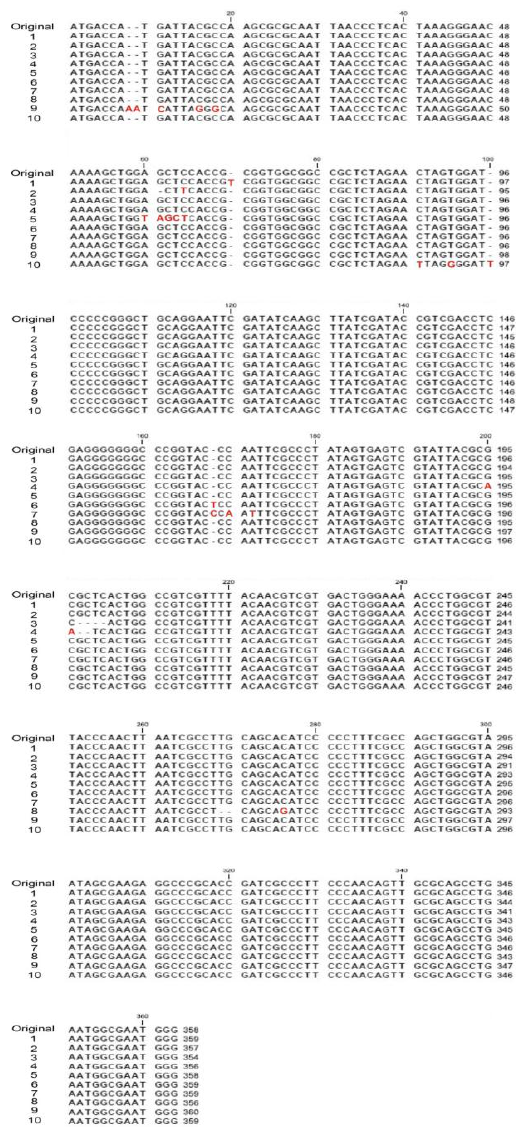
Figure 5. Mutation sites in the lac Z α-peptide coding ( lac Zα) region. Examples of DNA sequences in the lac Zα region of the white colonies are provided, in which insertion (Clones 1, 6, 7, 9 and 10) deletion (Clones 2–4, 8) and nucleotide substitution (Clones 2, 4, 5, 7, 8 and 10) mutation types are involved. The nucleotides at the mutation sites are labeled in red.